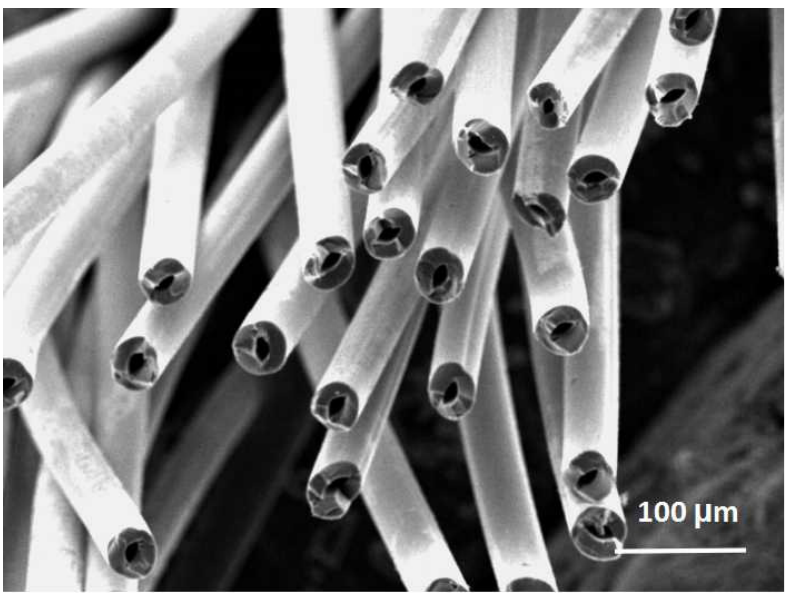
Figure 2. SEM image of the HGFs.